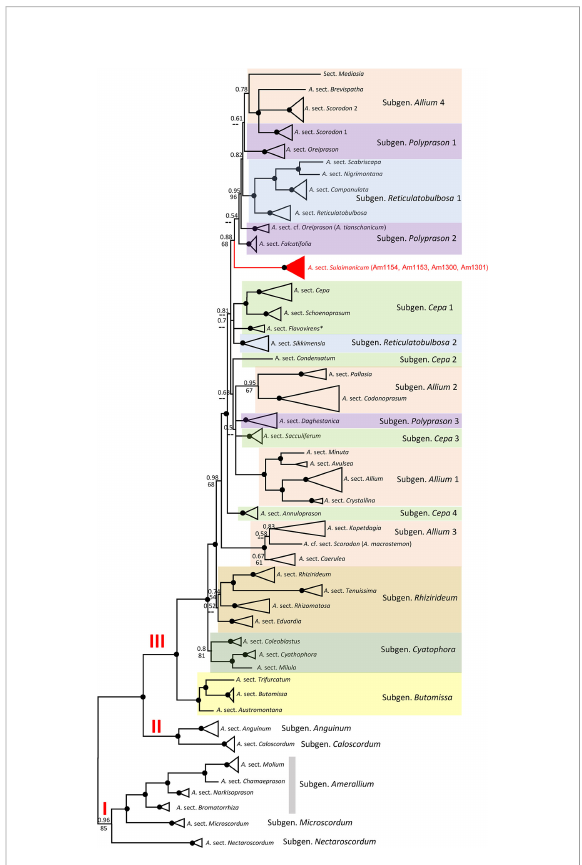
FIGURE 4 Generalised nrITS tree of the third evolutionary line of genus Allium . Numbers by nodes represent bootstrap support (1,000 replicates) and Bayesian probabilities. Roman numerals (I, II, and III) designate clades of three evolutionary lines. The joint presence of Bayesian probabilities over 0.98 and bootstrap support over 95% is indicated with a black